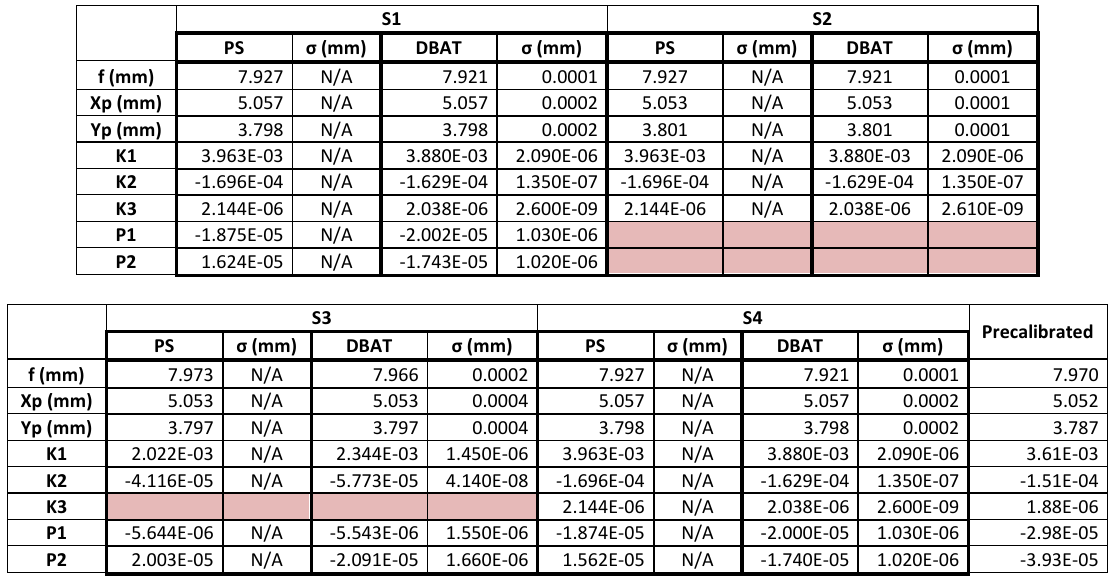
Table 2. The estimated parameters and standard deviations for four scenarios for the St-Pierre data set